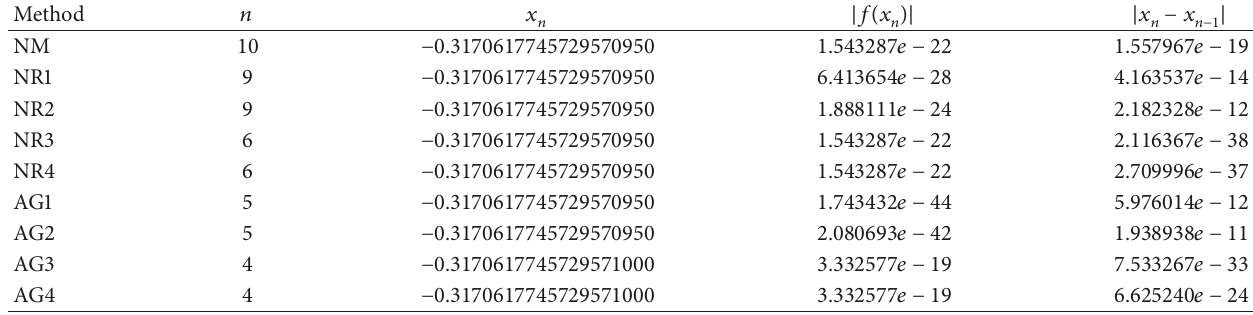
Table 2: Numerical results for motion of a particle (equation (73))